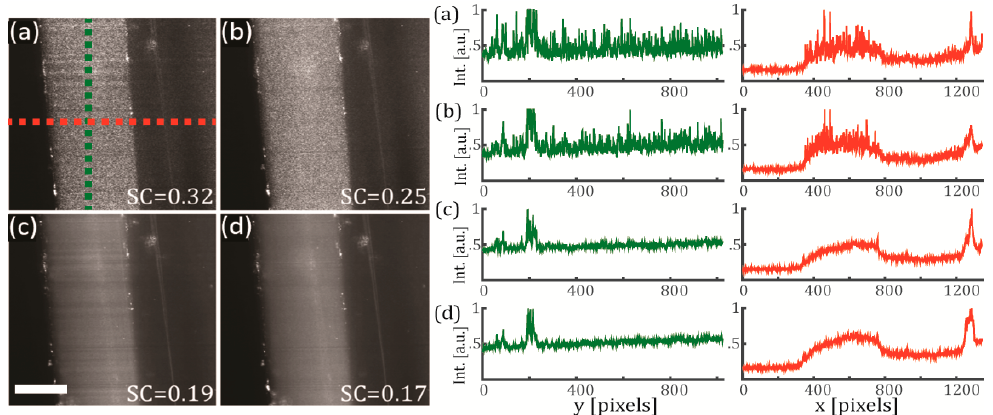
Figure 3. Effects of the coherence reduction on the speckle noise using a sample of FEP and agarose. The test sample is the FEP-tube wall. ( Left ) Single optical sections for the four different cases of study (integration time of 500 ms) and (right) their corresponding line intensity profiles along y (green) and x (red) axes. In ( a ) a diode laser (high temporal coherence) emitting at 638 nm is used for generating a static illumination light sheet (colored lines are the paths were the line intensity profiles were measured). In ( b ) same configuration as (a), but the light sheet pivots at 100 Hz regarding the centre of the FOV. In ( c ) a SCL (low temporal coherence) emitting a broadband spectrum of 140 nm (centred at 600 nm) is used for generating a static illumination light sheet. In ( d ) same configuration as (c), but the light sheet pivots at 100 Hz regarding the centre of the FOV. Scale bar 100 μ m.